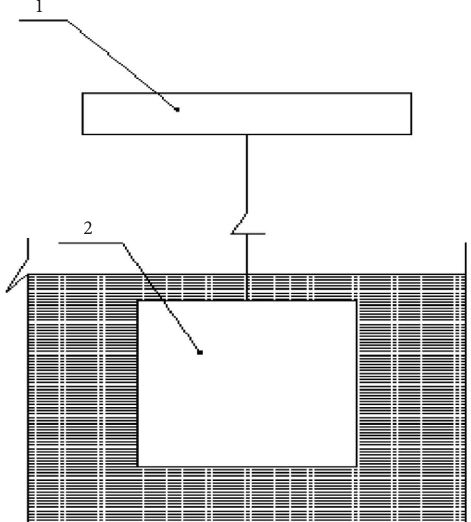
Figure 9: Experimental device for porosity measurement. (Note: 1-electronic balance, 2-permeable concrete test block).